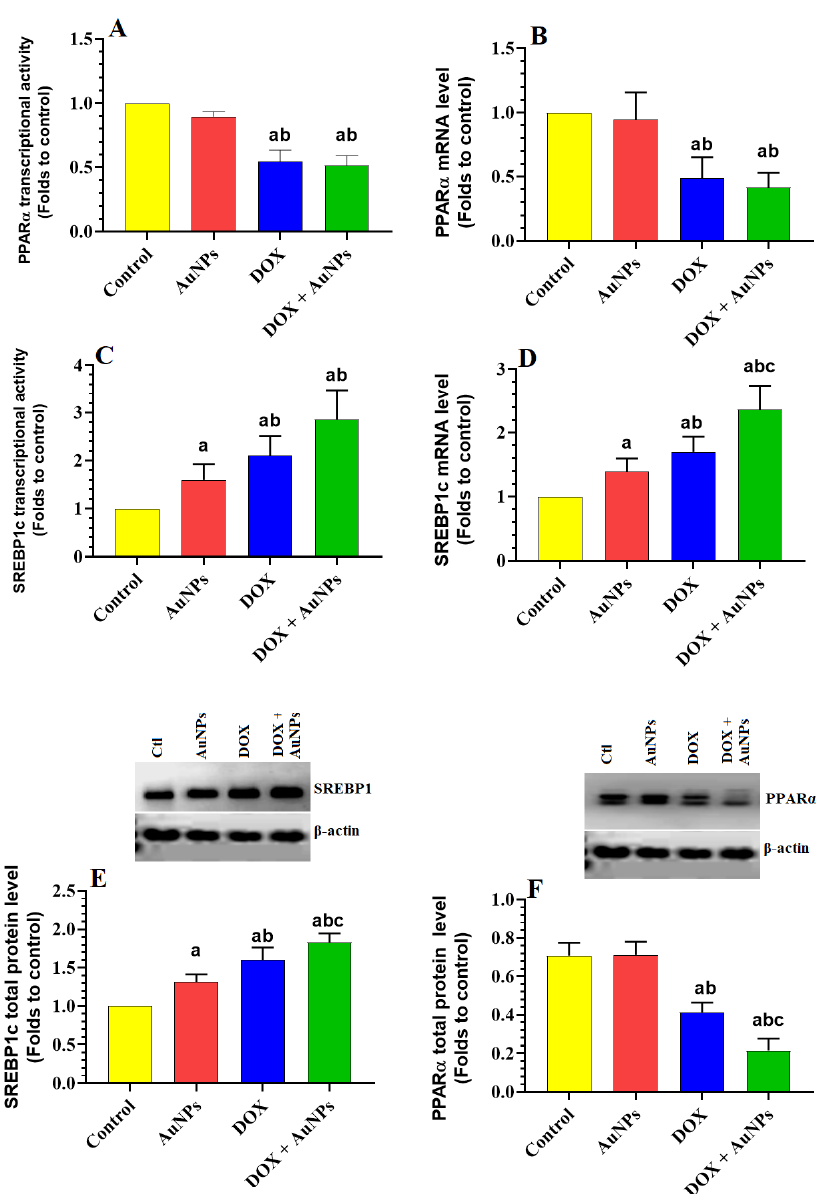
Figure 3. Effects of the individual or combined treatments with gold nanoparticles (AuNPs) and/or doxorubicin (DOX) on the transcription, total levels, and nuclear transcriptional activity of PPAR α ( A , B , F ) and SREBP1 ( C , D , E ) in the liver of all experimental groups. Data were analyzed by 1-way ANOVA followed by Tukey’s test. Values are presented as means ± SD ( n = 8/group). Significance was considered at p < 0.5. a : vs. control rats; b : vs: AuNPs-treated rats; c : vs. DOX-treated rats.